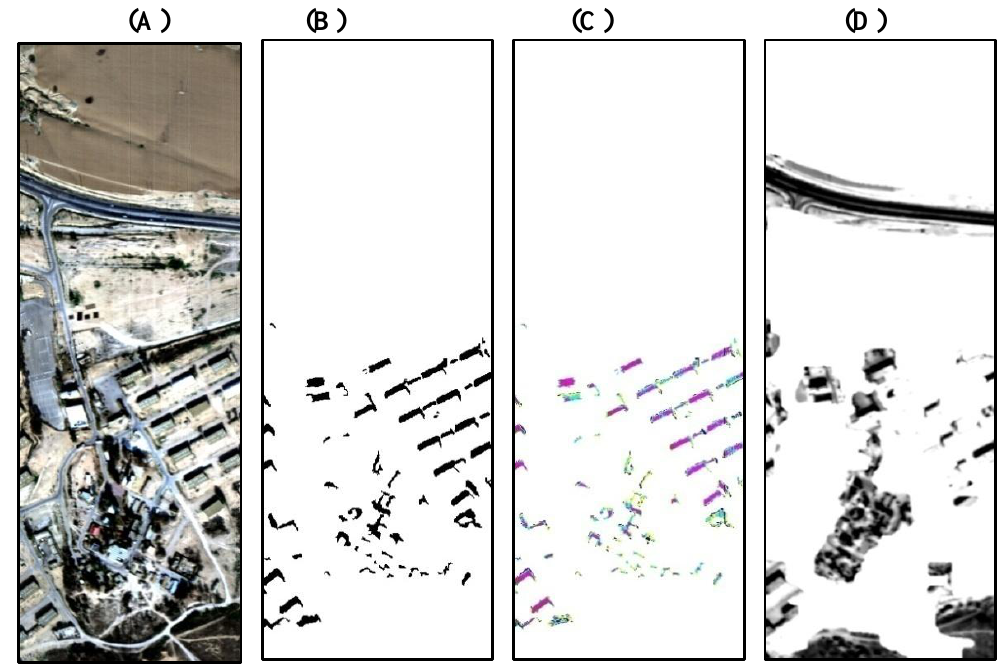
Figure 6. Shadow masks as generated from the original AISA-Dual image: (A) RGB natural color composite AISA-Dual image (18 December 2009; 11:30 GMT; 15 km visibility; midlatitude winter model; 60° solar zenith; 205.8° azimuth angle), (B) boresight shadow mask, (C) boresight shadow estimation (#4 (yellow) 10–20%, #3 (cyan) 20–50%, #2 (magenta) 50–80% and #1 (maroon) 80–100%), (D) ATCOR-4 shadow mask.